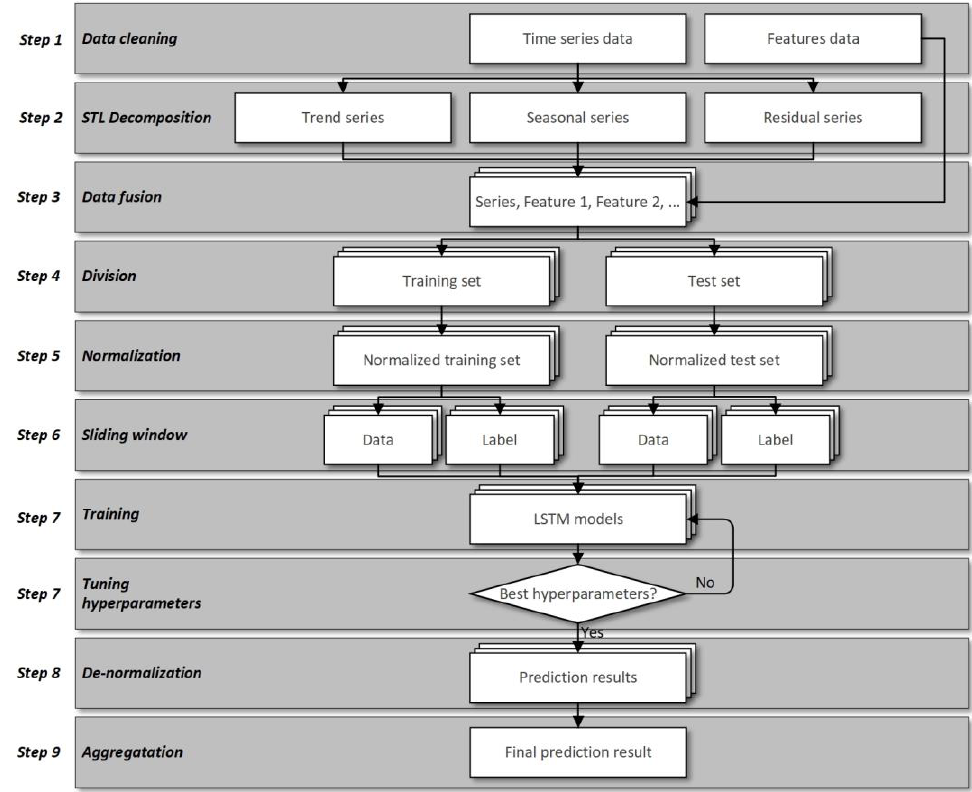
Figure 1. Flowchart of ISTL-LSTM .